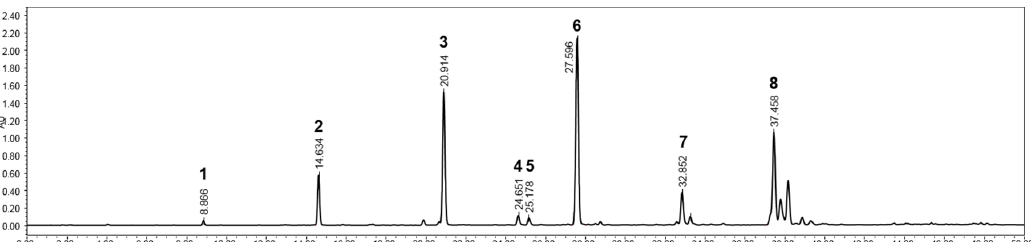
Figure 4. HPLC profile of the BRE derived from B. rotunda rhizomes. The chromatogram was based on the following conditions: a linear gradient solvent system of acetonitrile and 0.1% HCOOH-containing water, ranging from 20% to 90% acetonitrile, for 40 min, followed by isocratic elution with 100% acetonitrile for 10 min, on a SunFire C18 (5 µ m, 4.6 × 150 mm) waters column, at a flow rate of 1.0 mL / min, and detection under 300 nm; naringenin 5-methyl ether ( 1 ), alpinetin ( 2 ), pinocembrin ( 3 ), cardamonin ( 4 ), pinostrobin chalcone ( 5 ), pinostrobin ( 6 ), 4-hydroxypanduratin A ( 7 ) and panduratin A ( 8 ).